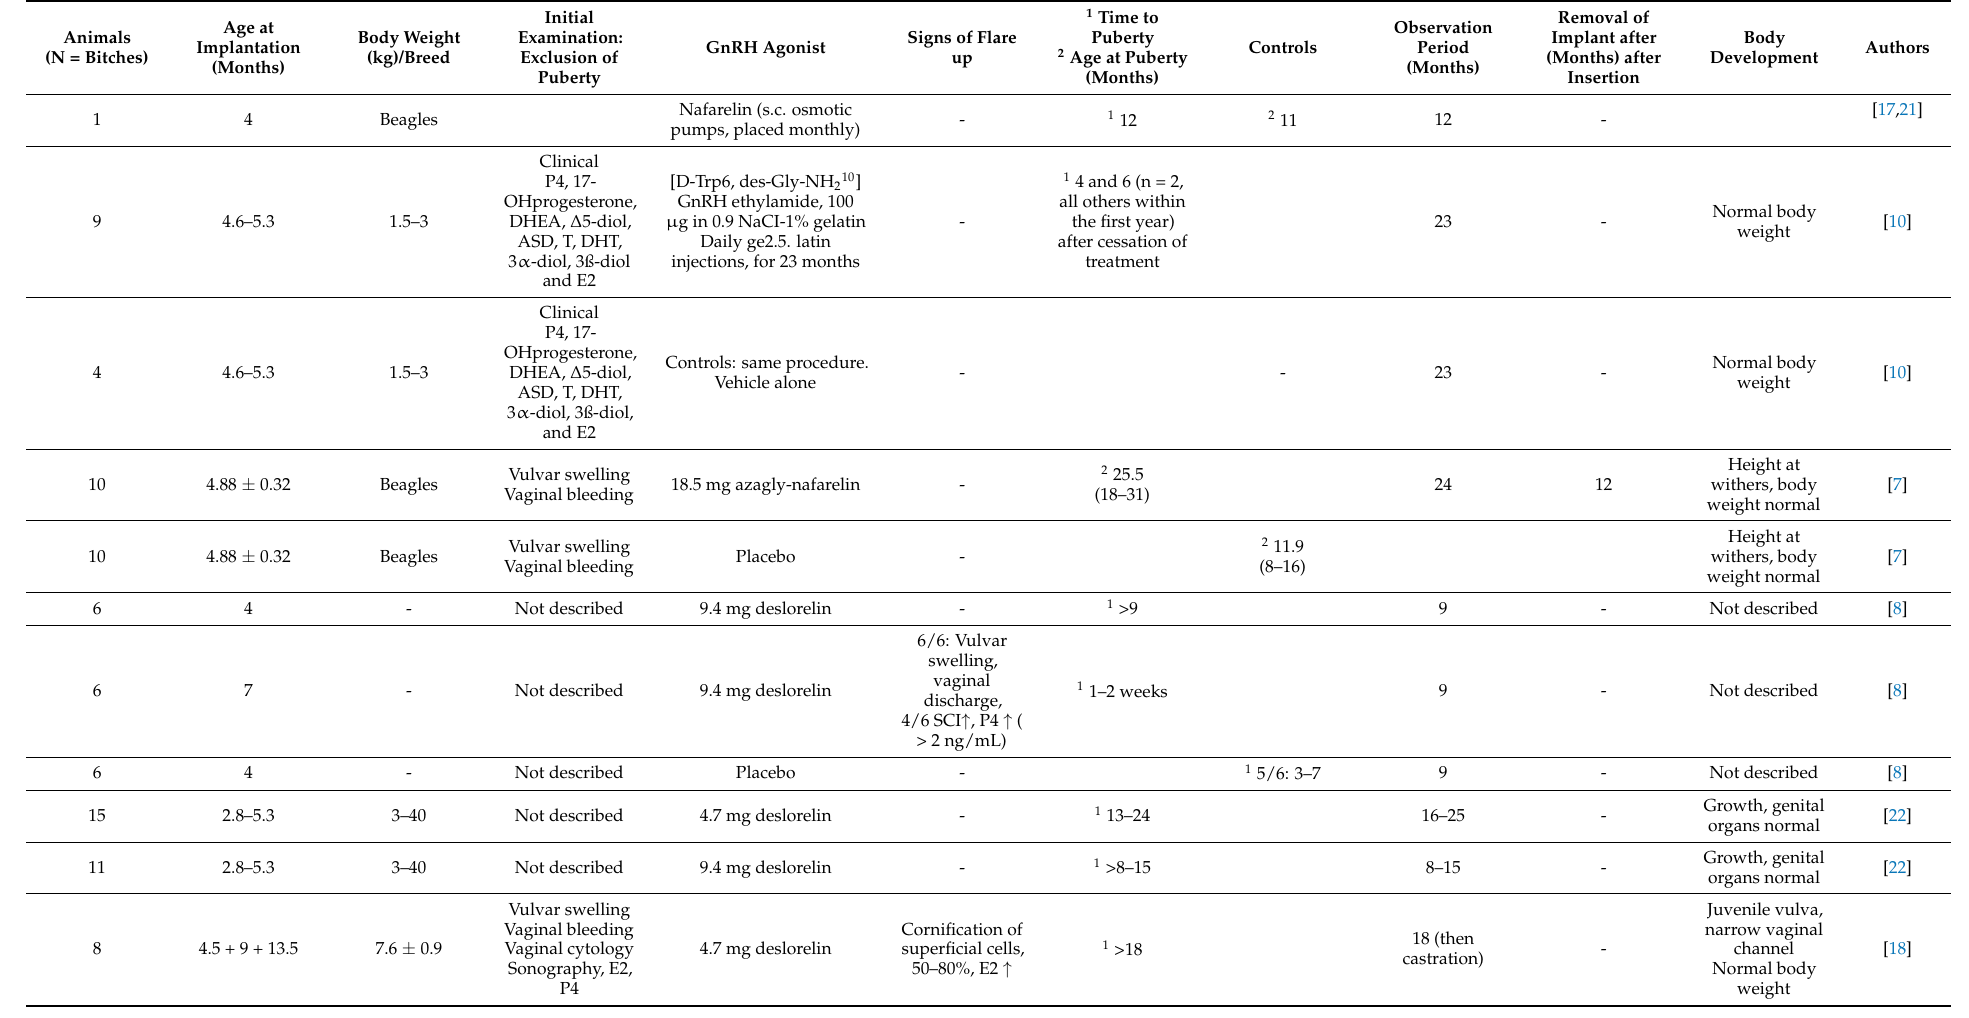
Table 1. Experiments using GnRH agonists for postponement of puberty in female